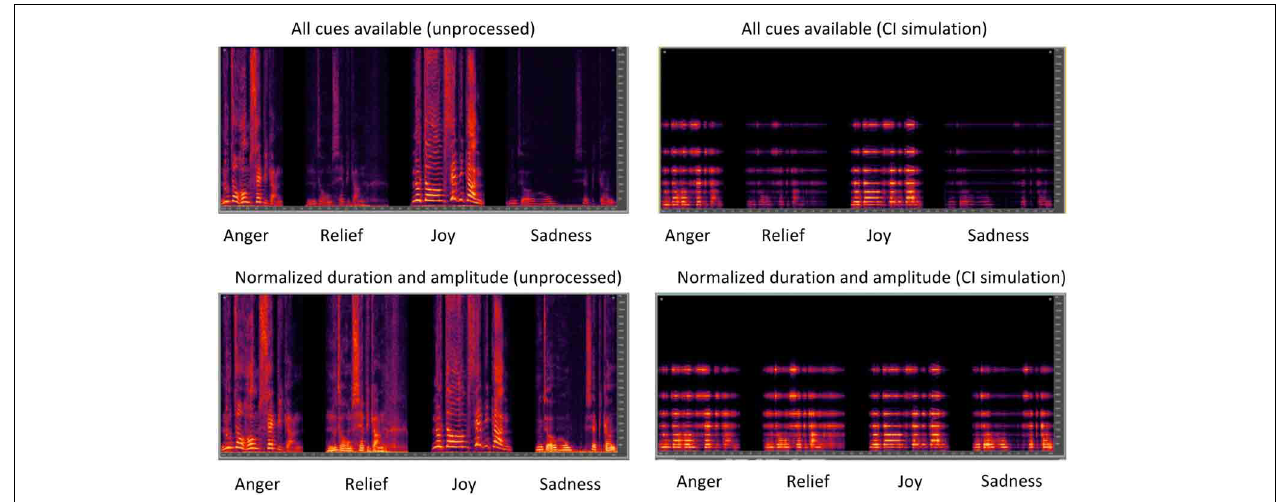
FIGURE 5 | Spectrograms for Dutch nonsense words produced according to four target emotions. The left panels show unprocessed speech and the right panels show speech processed with the CI simulation.